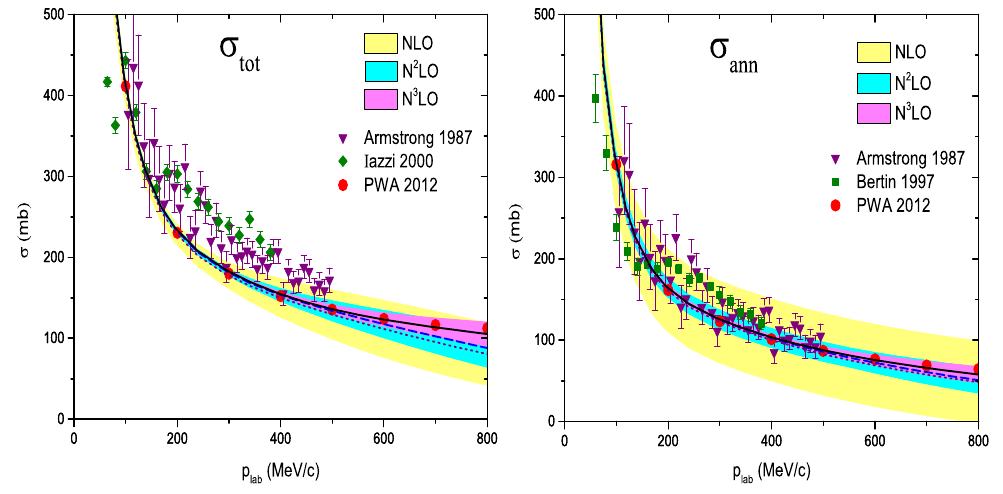
Figure 15 . Total ( (cid:27) tot ) and integrated annihilation ( (cid:27) ann ) cross sections for (cid:22) np scattering. Nota- tions are described in the text. Data are taken from refs.